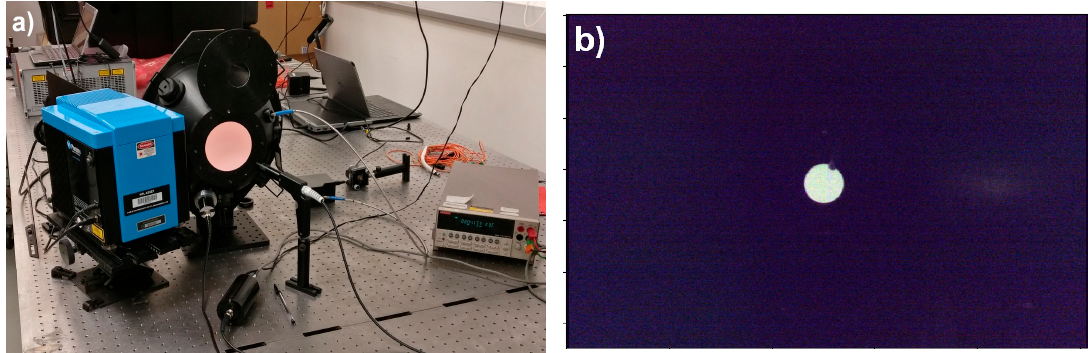
Figure 2. ( a ) The measurement setup for spectral response characterisation. Broadband light from a supercontinuum laser source (background) is directed to a monochromator (left) via an optical fibre. Resultant monochromatic light is fed to an integrating sphere, where a photodiode is used to monitor the light intensity. ASD FieldSpec pro is also used to monitor the output port (the optics and optical fibre visible in front of the sphere) ( b ) A FPI image of the integrating sphere port acquired in the calibration.